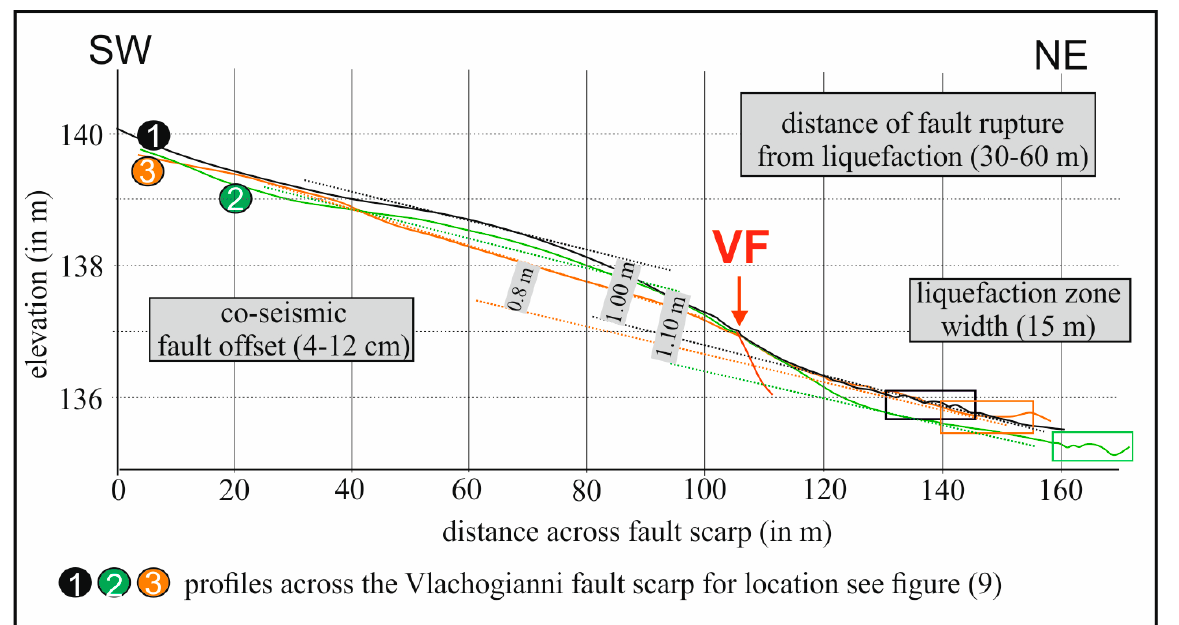
Figure 6. Drone capture of coseismic surface trace ( a ), as mapped on 4 March and its outline ( b ). This crack shows a maximum verticaloffset of 10 cm, and its surface trace is parallel with VF. Total trace of mapped rupture is ca. 1 km. Drone back-pack (in the red circle, 80-cm-long by 40-cm-wide) is used for scale.